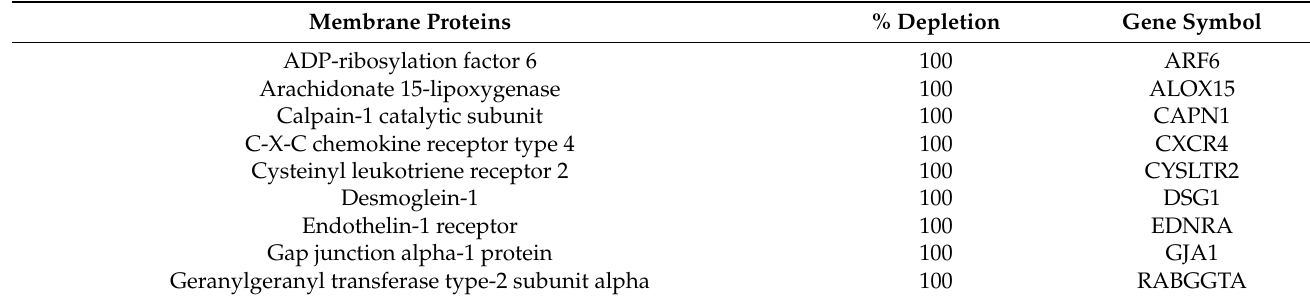
Table A2. Membrane proteins depleted during